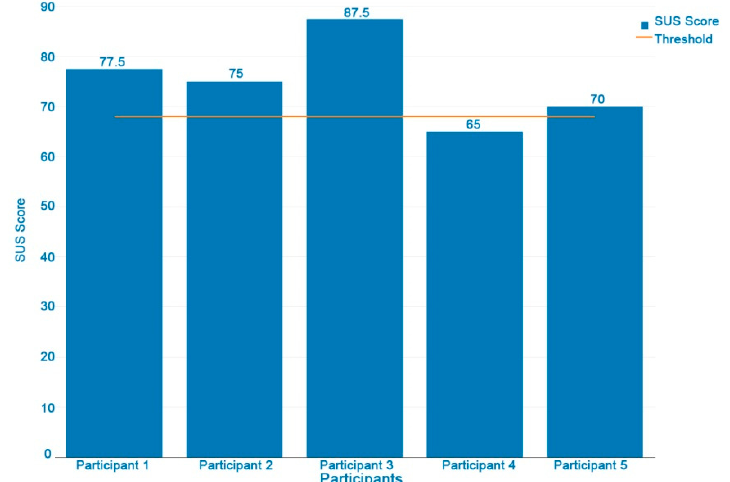
Figure 9. Graph of the results of the system usability scale (SUS) questionnaire. All the results exceed the threshold of 68 points (50th percentile) and represent an acceptable level of perceived usability of the system [29].